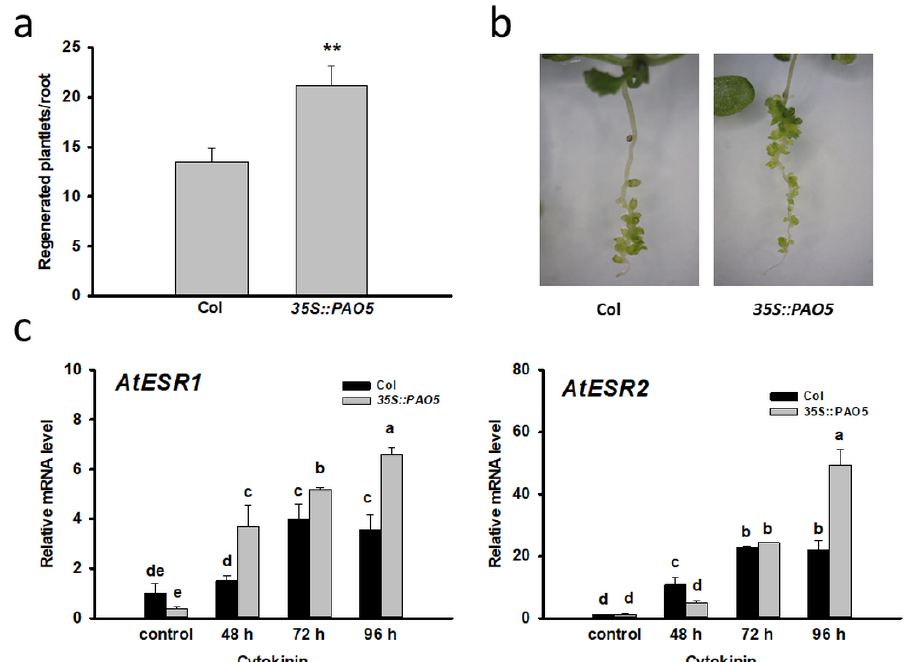
Figure 4. Ectopic overexpression of AtPAO5 enhances the conversion of lateral root primordia into shoots. ( a ) Shoot regeneration of seedling roots of WT (Col) and AtPAO5 overexpressing transgenic ( 35S::PAO5 ) plants 10 days after cytokinin induction. Data are means ± SE of three biological replicates with 20 seedlings each. For significance analysis Student’s t -test was used (** p ≤ 0.01). ( b ) Representative images of regenerating seedlings. ( c ) Relative mRNA levels of AtESR1 and AtESR2 genes in wild type (Col) and AtPAO5 -overexpressing ( 35S::PAO5 ) seedling roots after 48, 72 and 96 h of cytokinin induction representing the organ conversion (48 h), the early (72 h) and late (96 h) shoot promeristem phases [7]. The mRNA levels of the UBIQUITIN 1 (At3G52590) and PP2A3 (At1G13320.1) genes were used for gene expression normalization. The mRNA level of the untreated root tissue was used as control (relative mRNA level: 1). Data were averaged from three independent biological experiments with three technical replicates each. Standard errors are shown on the columns. The significance of differences between sets of data was determined by one-way analysis of variance (ANOVA) following Duncan’s multiple range tests; a p -value of less than 0.05 was considered significant as indicated by different